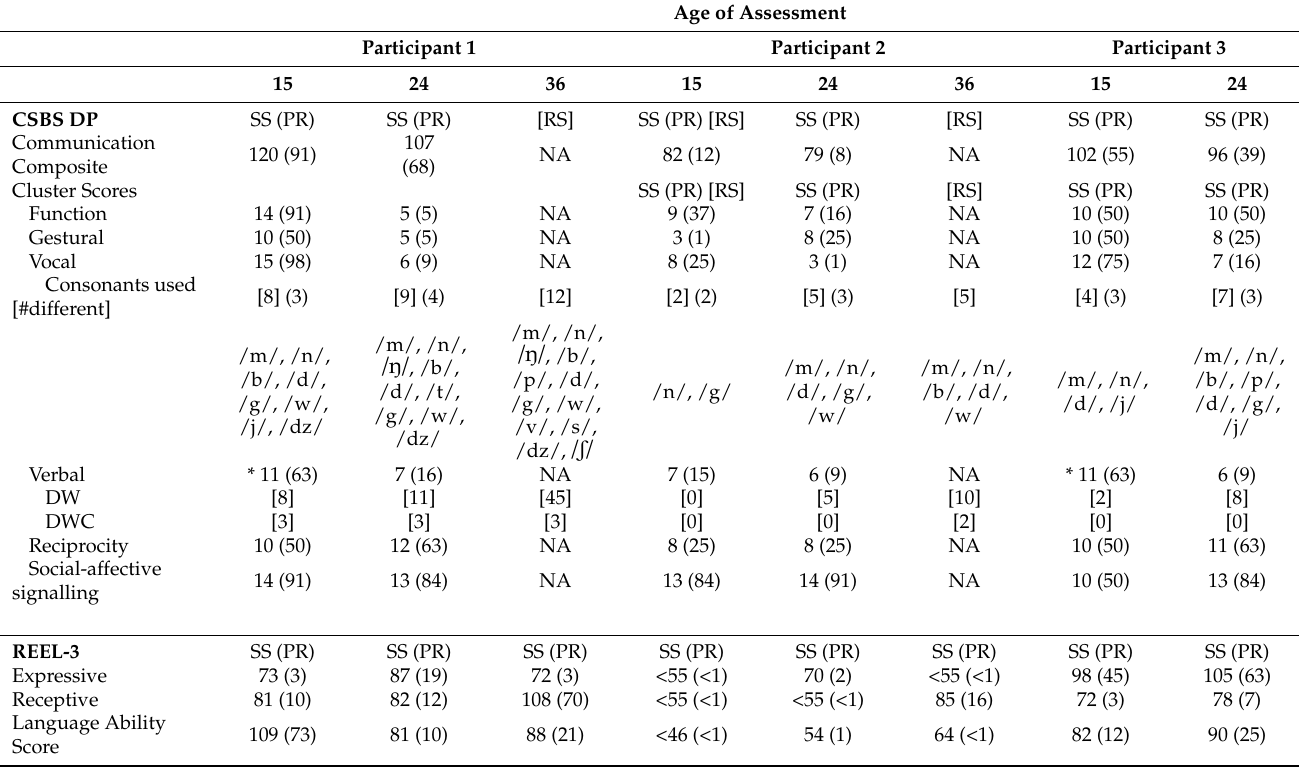
Table 2. Communication Status as Measured Across the Study Phases.